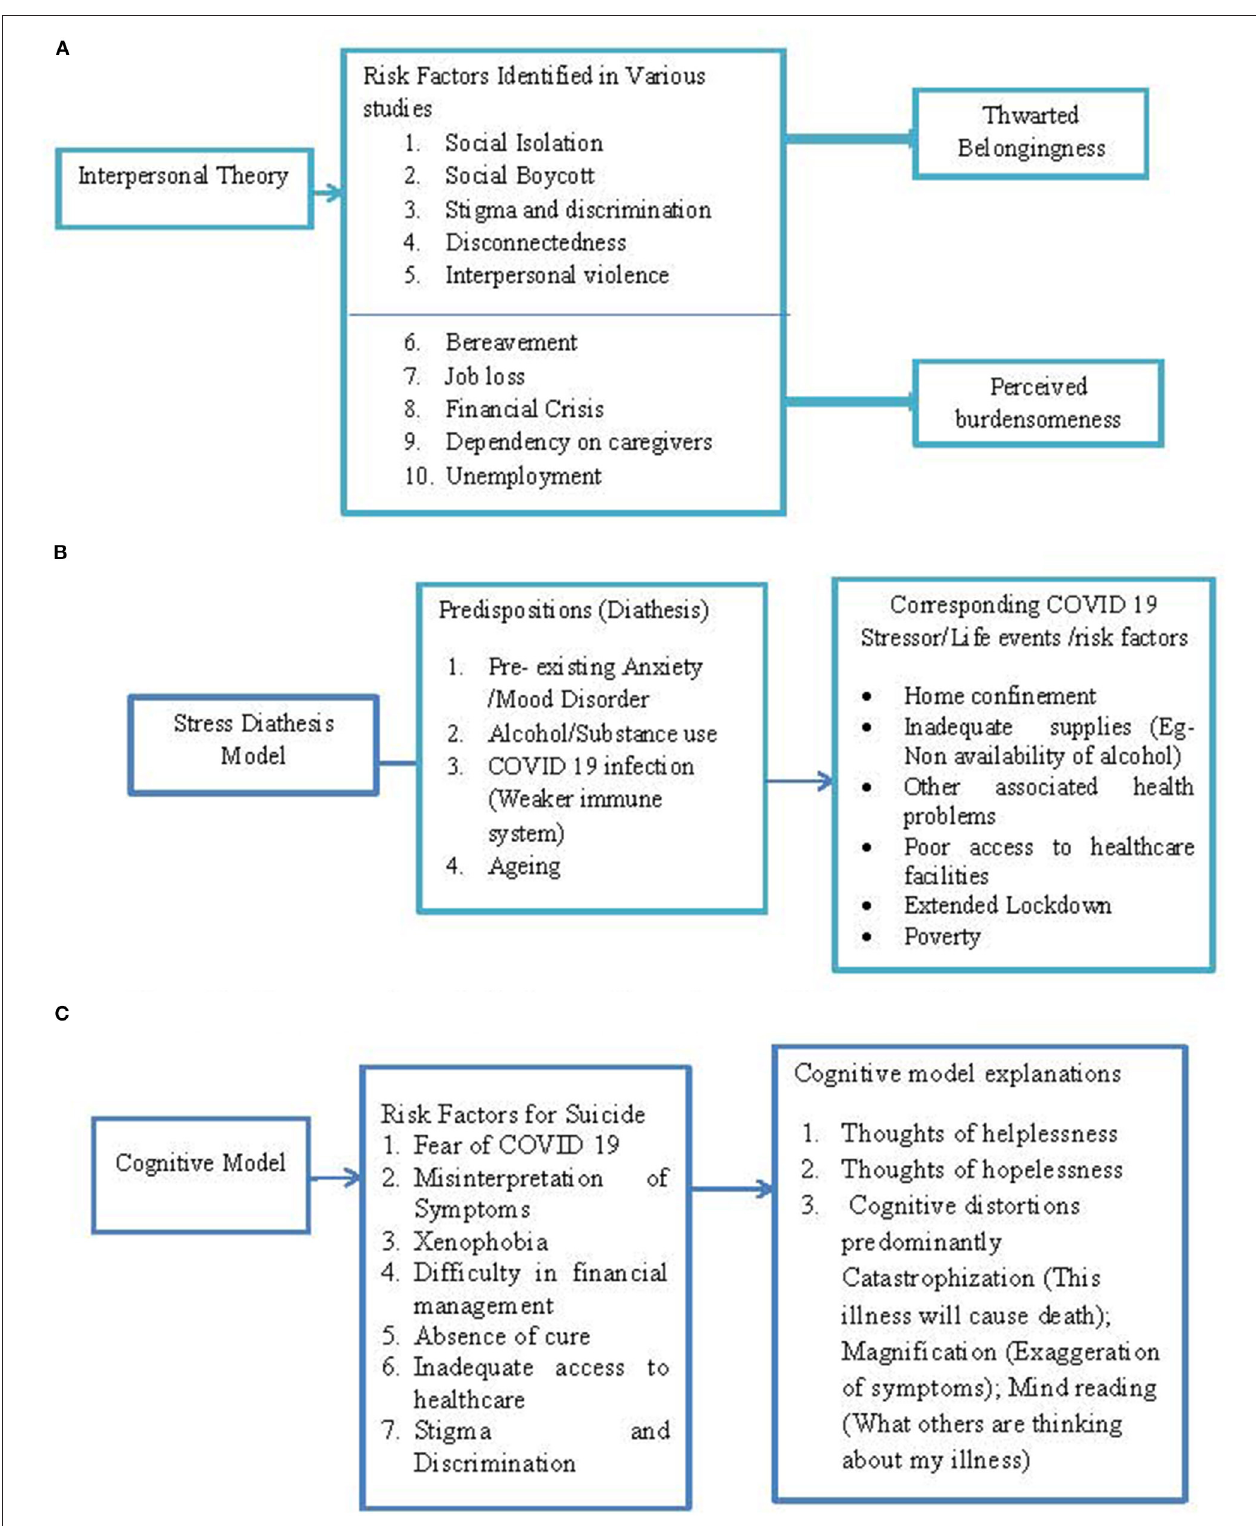
FIGURE 1 | (A) Representation of risk factors through interpersonal model. (B) Representation of risk factors through stress diathesis model. (C) Representation of risk factors through cognitive model.